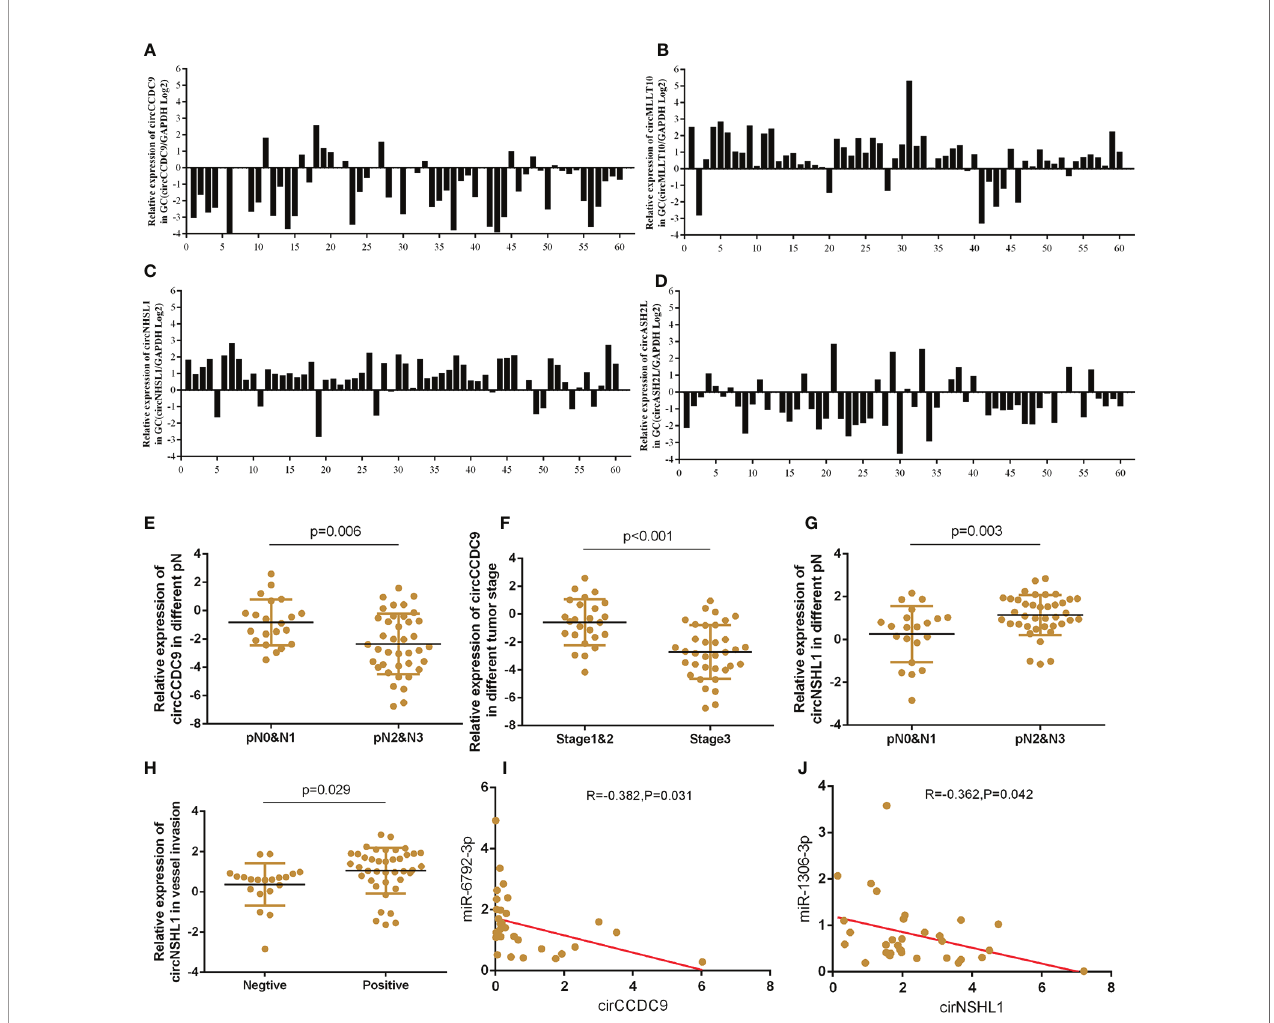
FIGURE 7 | The expressions of circRNAs GC tissues and clinical information analysis. (A – D) Expression of circASHL2, circCCDC9, circNHSL1 and cirMLLT10 in GC tissues compared to normal controls. (E, F) The expression of circCCDC9 was negatively associated with TNM stage and lymphatic metastasis. (G, H) The expression of circNHSL1 was positively associated with vessel invasion and lymphatic metastasis. (I) The expression of circNHSL1 was negatively associated with that of miR-1306-3p. (J) The expression of circCCDC9 was negatively associated with that of